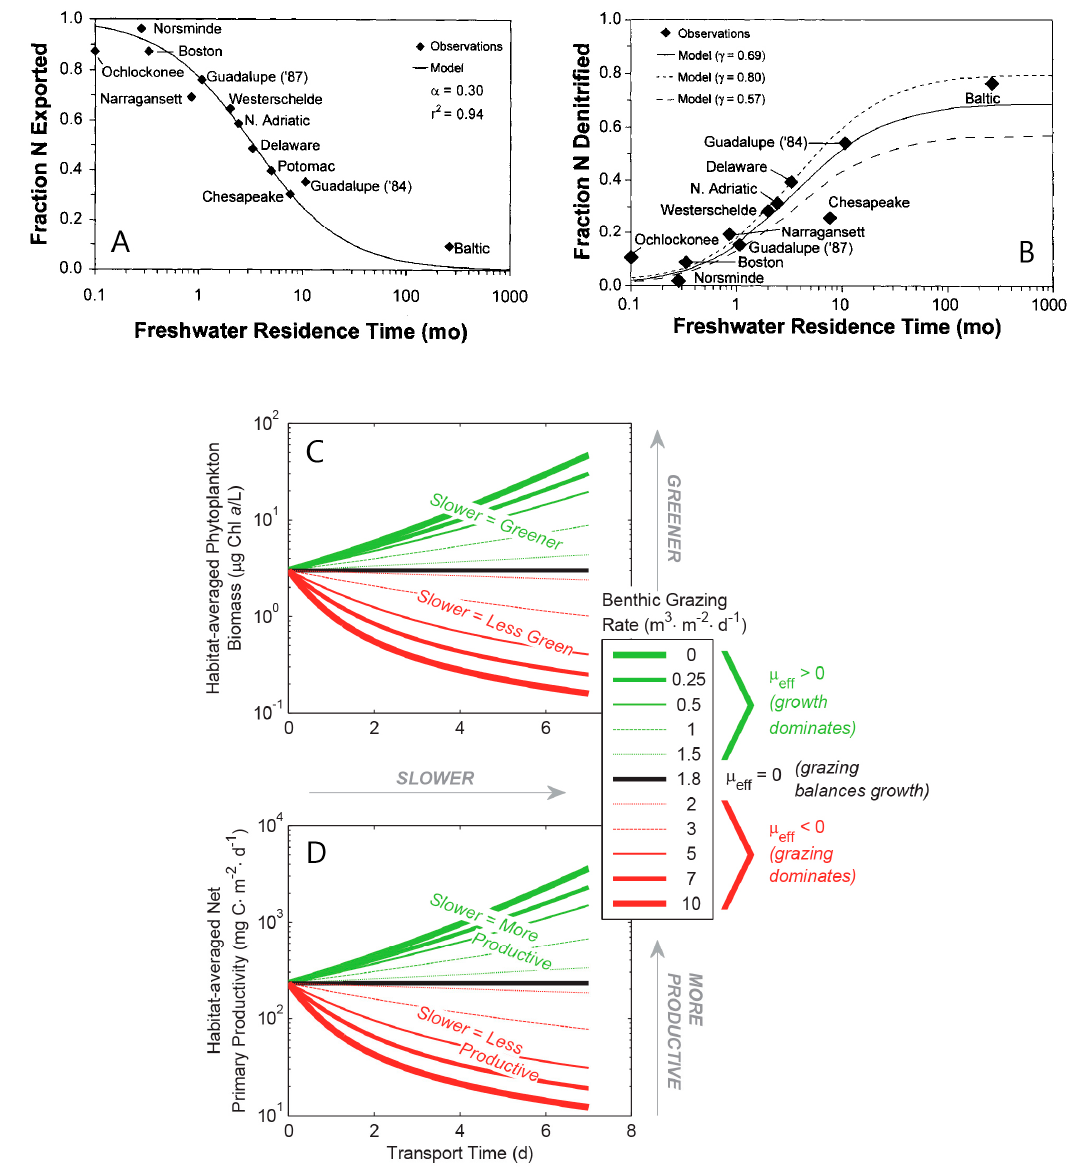
Figure 13. Dettmann’s [214] simple models for fraction of upland nitrogen loading to an estuary that is ( A ) exported (Equation (2) herein) and ( B ) denitrified (Equation (3) herein), expressed as functions of “freshwater residence time” and fit to data for several estuaries. “ γ ” in Dettmann’s [214] denitrification plot ( B ) is referred to as “ ε ” in Equation (3) and the text herein. (Modified from Dettmann [214].) Calculations of habitat-averaged phytoplankton ( C ) biomass and ( D ) productivity based on Lucas and Thompson’s [215] simple models expressed as a function of transport time (Equation (4) herein for algal biomass). (Modified from Lucas and Thompson [215]).